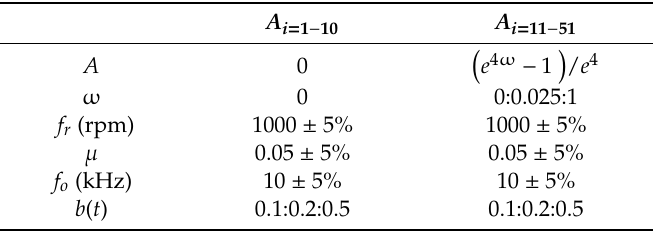
Table 4. Simulation characteristics.